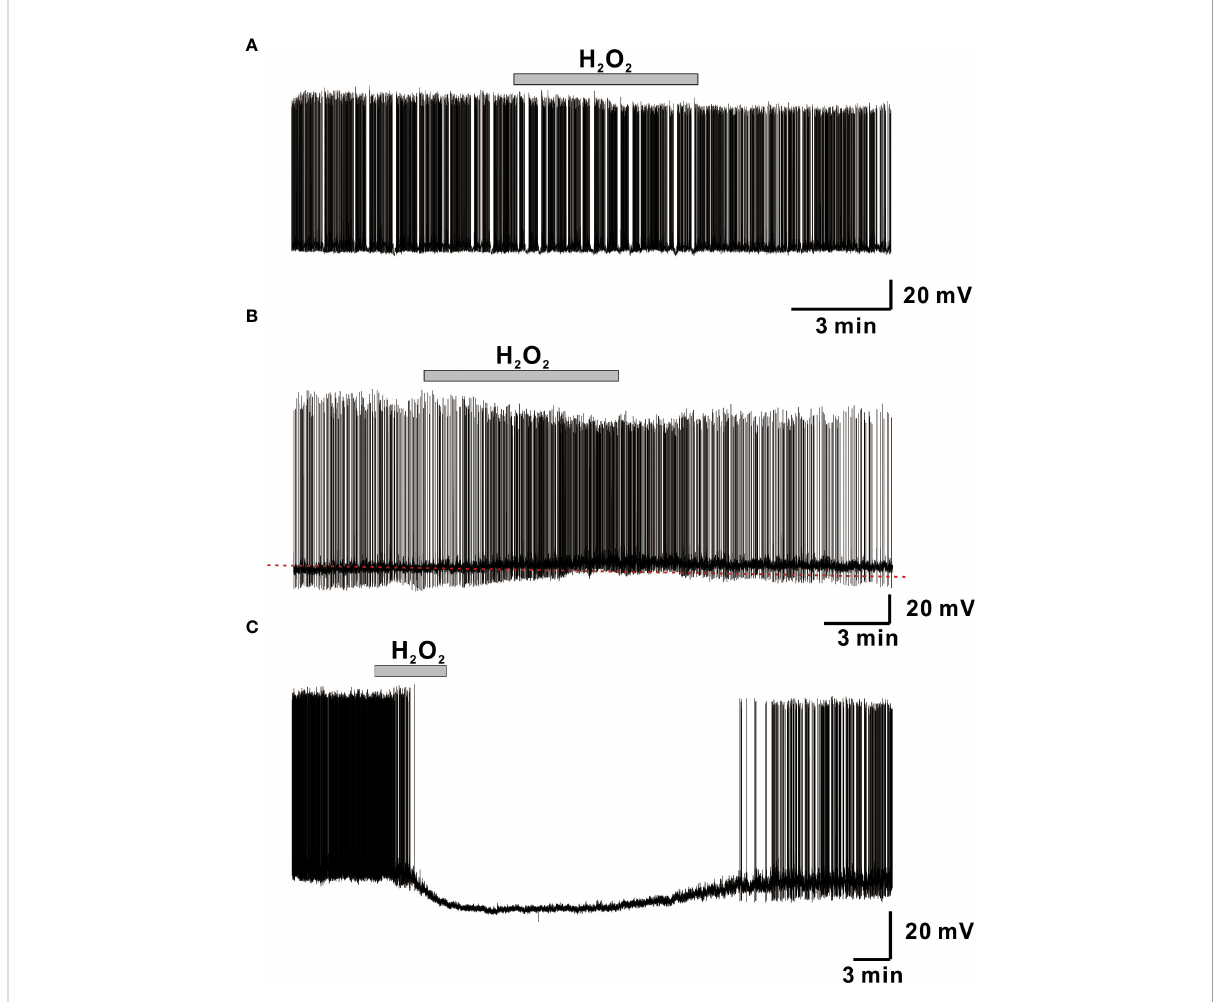
FIGURE 1 H 2 O 2 induces variegated responses of adult male GnRH neurons. (A – C) Representative voltage traces from GnRH neurons showing no response, membrane depolarization, and membrane hyperpolarization, respectively, upon perfusion with 1 mM H 2 O 2